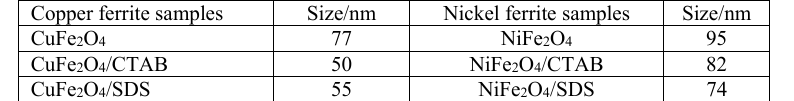
Table 1. Average size of the produced spinel Copper ferrite samples Size/nm Nickel ferrite samples Size/nm